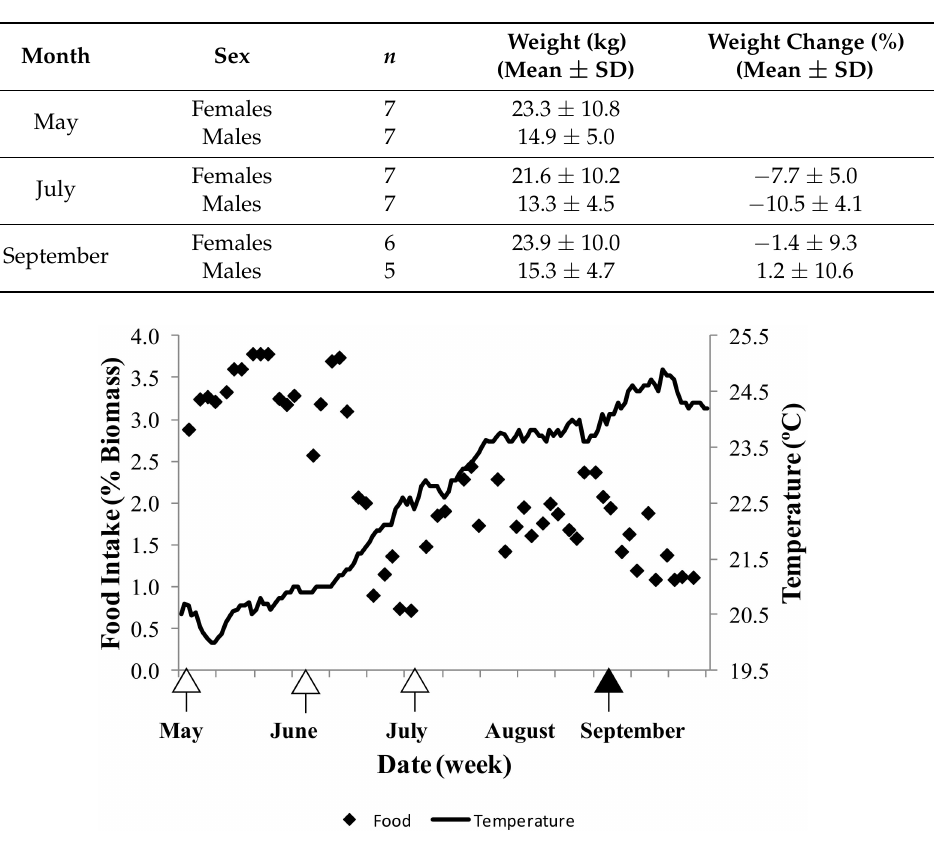
Figure 1. Temperature (solid line) and food intake (black rhombus) during the experimental period. White arrowheads in the X -axis indicate the GnRHa treatment and sampling times, and the black arrowhead indicates the final sampling